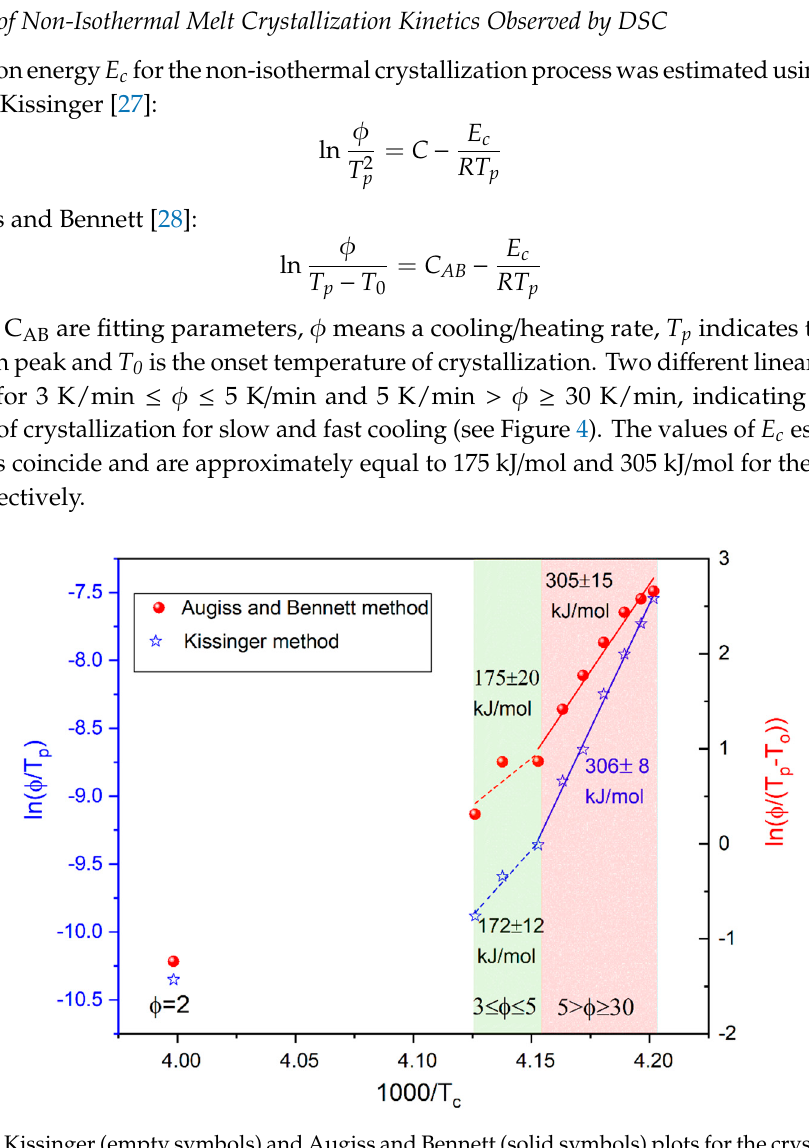
Figure 4. Kissinger (empty symbols) and Augiss and Bennett (solid symbols) plots for the crystallization process observed for BBOA upon cooling.